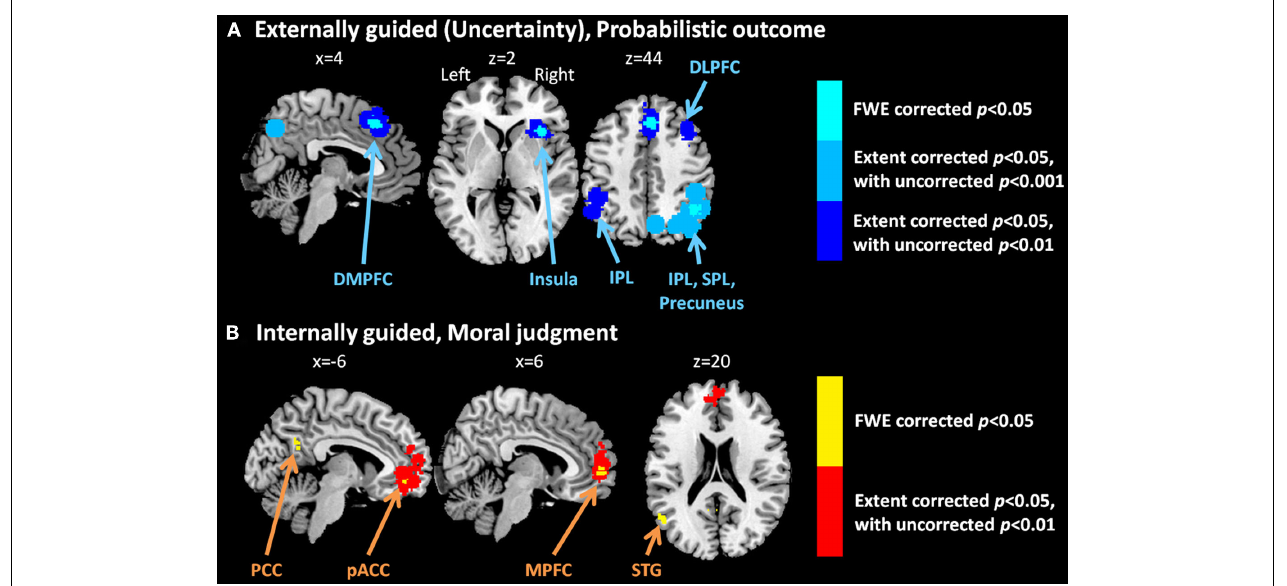
medium threshold of FWE corrected for the spatial extent at p < 0.05 with primary thresholds of uncorrected p < 0.01. No clusters were identified at the stringent threshold in preference judgment. DMPFC, dorsomedial prefrontal cortex; DLPFC, dorsolateral prefrontal cortex; IPL, inferior parietal lobule; SPL, superior parietal lobule; IFG, inferior frontal gyrus; pACC, perigenual anterior cingulate cortex; PCC, posterior cingulate cortex; MPFC, medial prefrontal cortex; STG, superior temporal